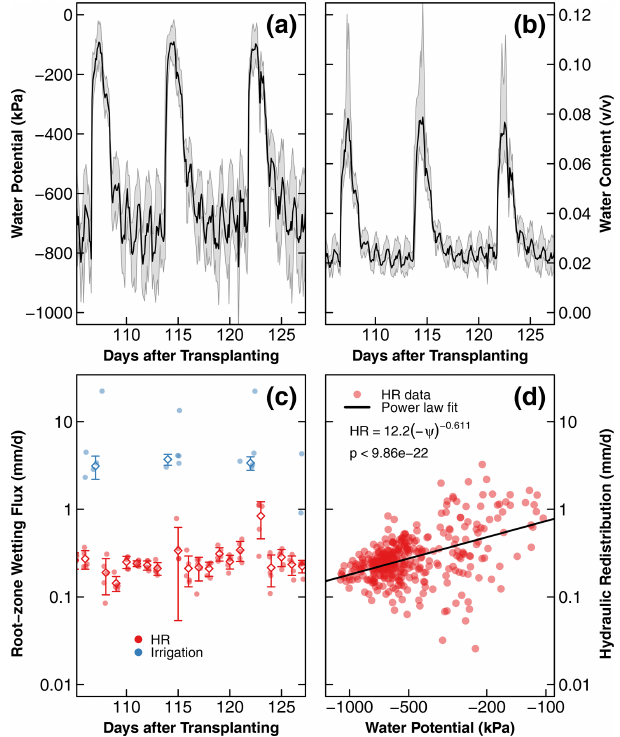
Figure 7. Changes in soil water potential (a) , water content con- verted from soil water potential (b) , and root zone wetting flux (c) from HR and irrigation as a function of time in the dry compart- ment of treatment D during days 106 to 126 after transplantation. HR outflow magnitude is a function of water potential ( ψ ), where HR, described by a power law model, is shown as a solid line (d) . In (a) and (b) , the solid black lines and gray shading represent the average and the standard deviation of the soil water potential and converted water content from five sensors distributed in three repli- cate compartments. Similarly, in (c) , solid dots represent the calcu- lated water flux from five sensors, and the diamonds and whiskers show the average and standard deviation of the water flux. In (d) , the water flux from HR during the whole experiment was used. The long-term results of soil water potential and converted water content are provided in the Supplement.